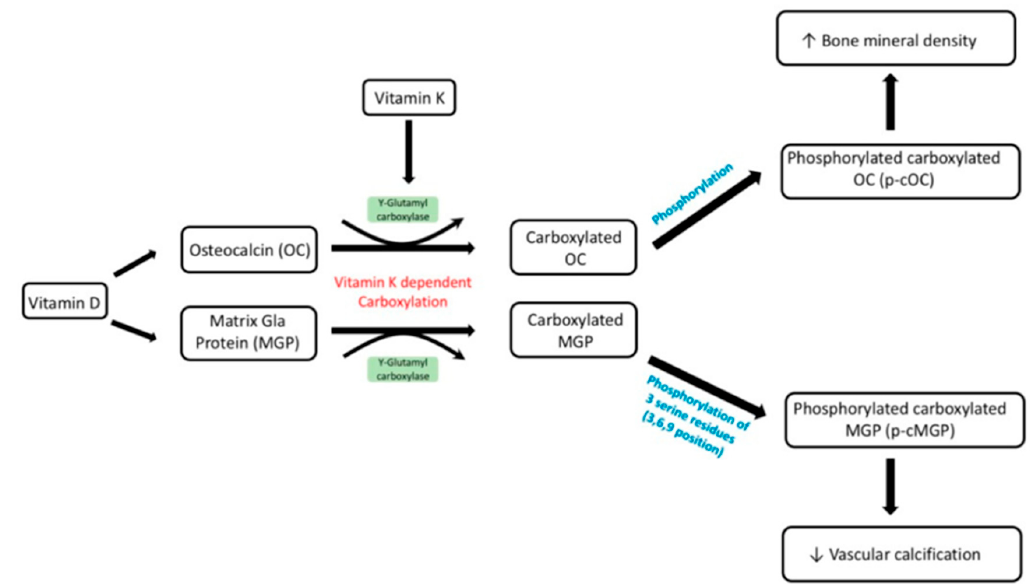
Figure 5. Metabolism of vitamin D and K. The active form of vitamin D can act as a transcription activator for the synthesis of OC and MGP. These are then carboxylated through the co-factors γ -glutamyl carboxylase and vitamin K. These proteins need to be further phosphorylated to enable normal physiological functions shown above, including phosphorylated carboxylated OC resulting in increased bone mineral density and phosphorylated carboxylated MGP decreasing vascular calcification. Multiple studies have demonstrated that vitamin D and K have a synergistic effect, and the diagram above outlines how they can be used in combination to prevent fractures in both healthy and osteoporotic subjects, as well as reducing vascular calcification. [47].